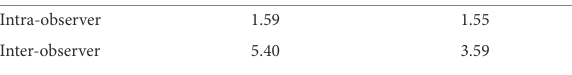
TABLE 2 The intra-and inter-observer variation